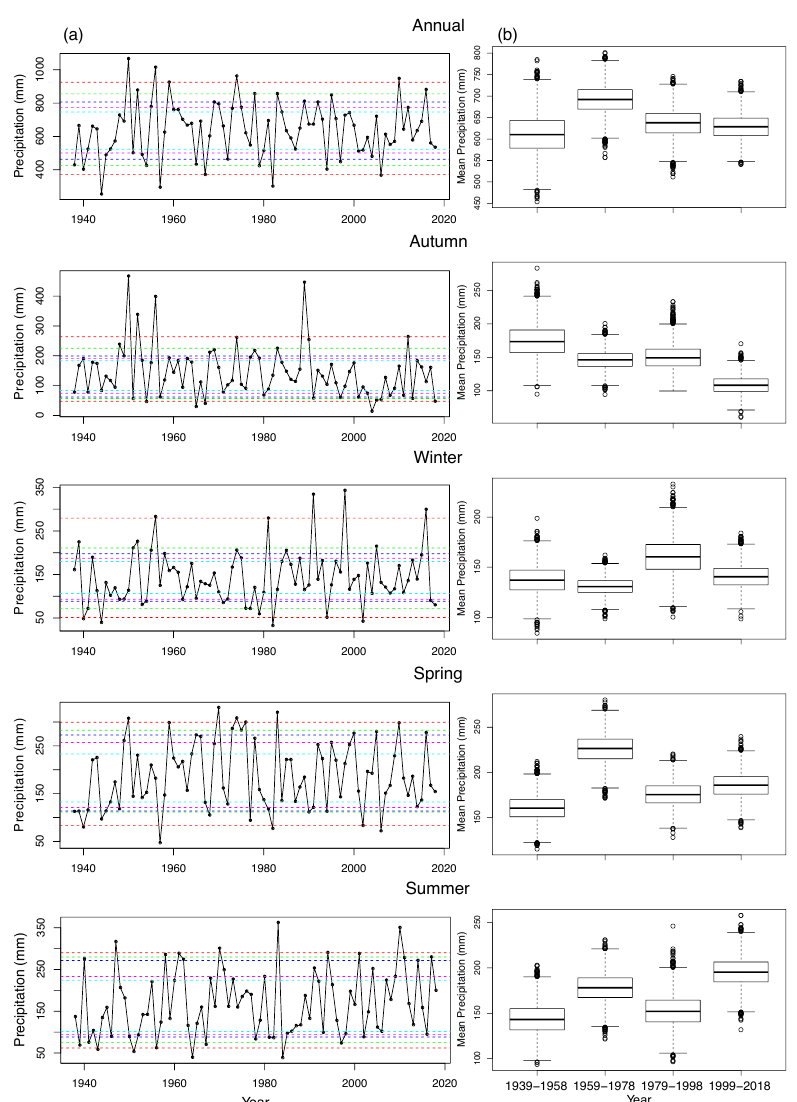
Figure 3. ( a ) Annual precipitation time series; and ( b ) box plots of the bootstrapped mean precipitation over 20-year periods for Canberra, both annually and for all four seasons. Dashed lines indicate the 5th and 95th (bottom and top red), 10th and 90th (bottom and top green) 15th and 85th (bottom and top dark blue), 20th and 80th (bottom and top pink), and 25th and 75th percentiles (bottom and top light